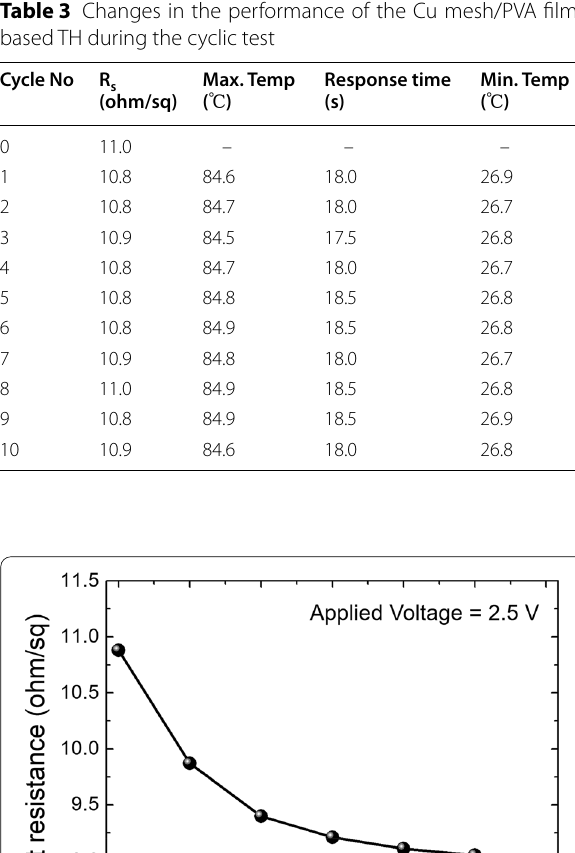
Table 3 Changes in the performance of the Cu mesh/PVA film‑